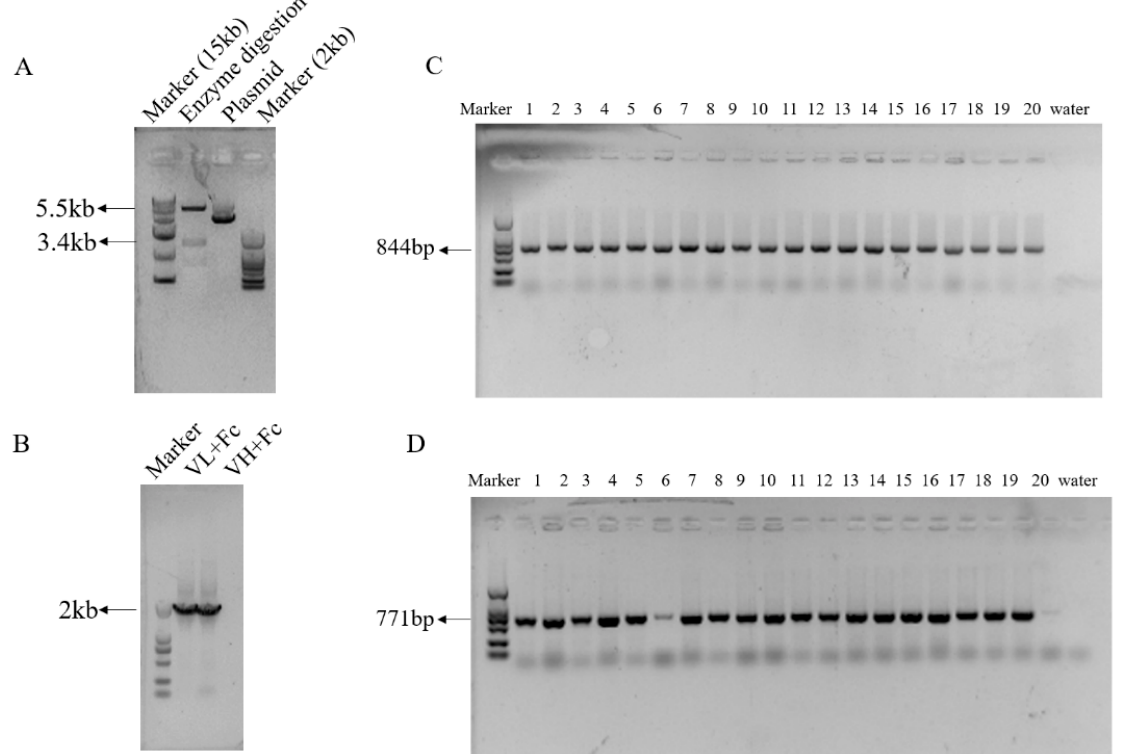
Figure 5. Construction of eukaryotic expression vectors containing PEDV neutralizing antibody genes. ( A ) pCI-Neo-hTERT digested with Nhe I and Sal I, and pCI-Neo-hTERT uncut. Empty vector is 5.5 kb. ( B ) Nhe I and Sal I digestion of pCI-anti-PEDV-VL and pCI-anti-PEDV-VH., VL-Fc and VH-Fc are 2 kb. ( C , D ) Colony PCR products from cells transfected with pCI-anti-PEDV-VL and pCI-anti-PEDV-VH. VL-Fc is 844 bp and VH-Fc is 771 bp.